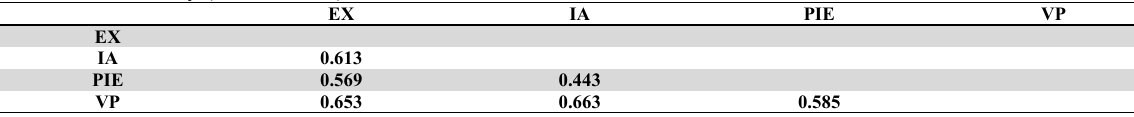
Discriminant Validity (HTMT Ratio)